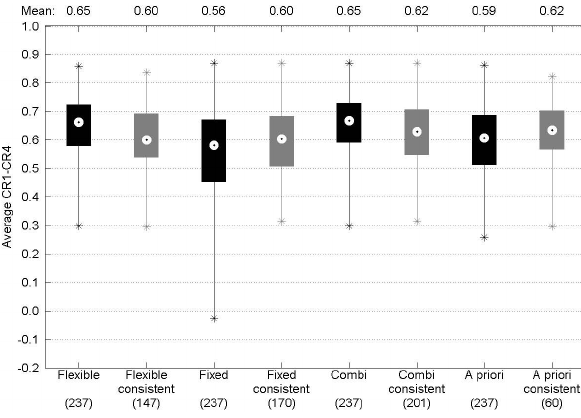
Fig. 6. Distribution of average performance in validation for the flexible, fixed, combined and a priori approaches. The whiskers de- note the minimum and maximum values, the shaded boxes indicate the 25th–75th percentiles, and the circles indicate the median value. The dark boxes represent the distributions including inconsistent results, and the grey boxes represent only consistent results. The number of catchments in each group is given in